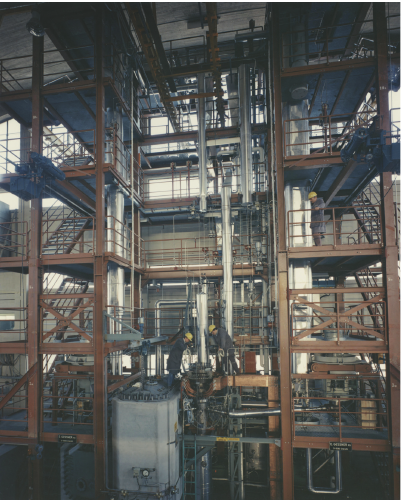
Figure 1: Photographic view of the LOBI test facility.